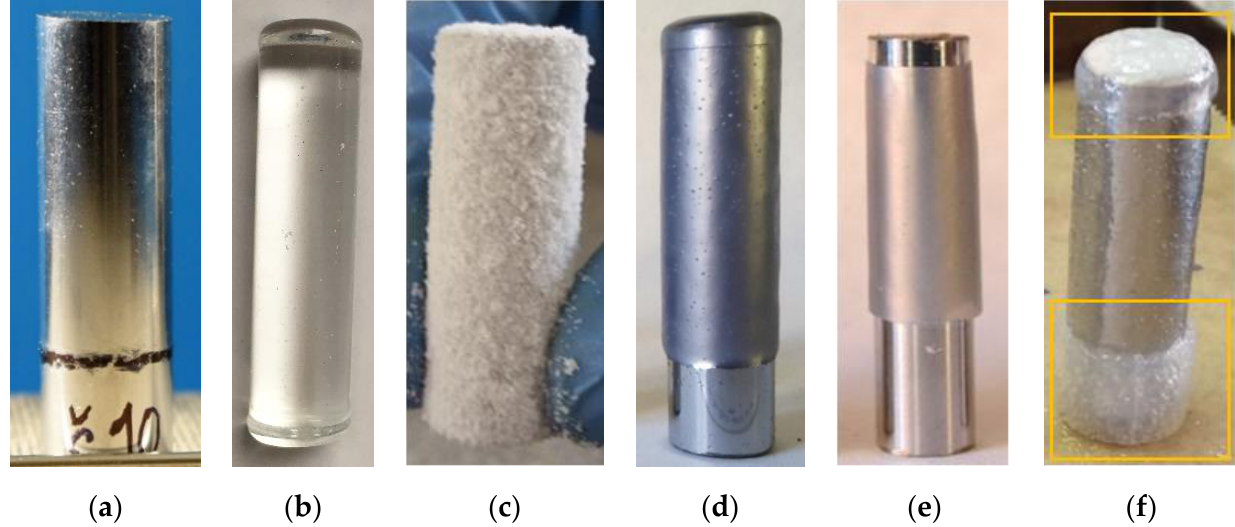
Figure 3. ( a ) Chrome-plated steel rod, diameter 12 mm; ( b ) glass rod, diameter 10 mm; ( c ) dip-coated rod; ( d ) sintered plastic layer; ( e ) cleared plastic layer; ( f ) use of silicone masking caps.